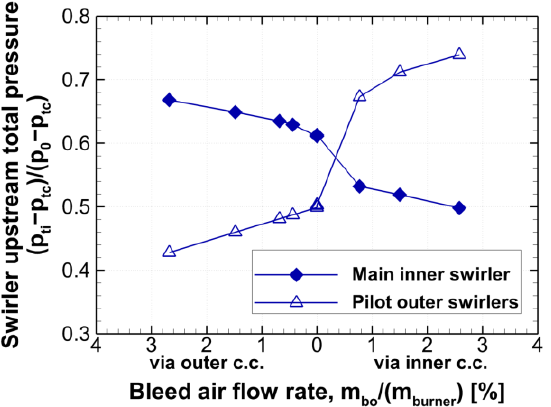
Figure 6. Swirler pressure loss in the burner containing the fluidic element. (Copyright by ASME — "Effects of Fluidic Control of Air-Flow Distribution on Staged Lean Jet Engine Burner," by Yoshida, Schneider, Hassa, Paper No: GT2016-57453).